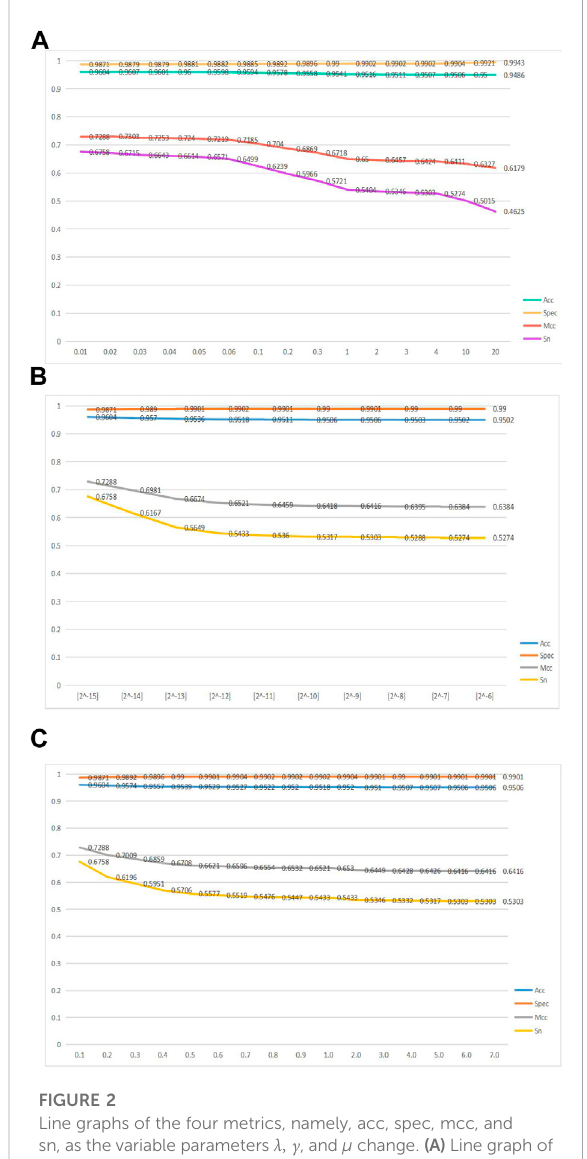
FIGURE 2 Line graphs of the four metrics, namely, acc, spec, mcc, and sn, as the variable parameters λ , γ , and μ change. (A) Line graph of Acc, Spec, Mcc, and Sn of GHKNN with the change in parameter λ . (B) Line graph of Acc, Spec, Mcc, and Sn of GHKNN with the change in parameter γ . (C) Line graph of Acc, Spec, Mcc, and Sn of GHKNN with the change in parameter μ